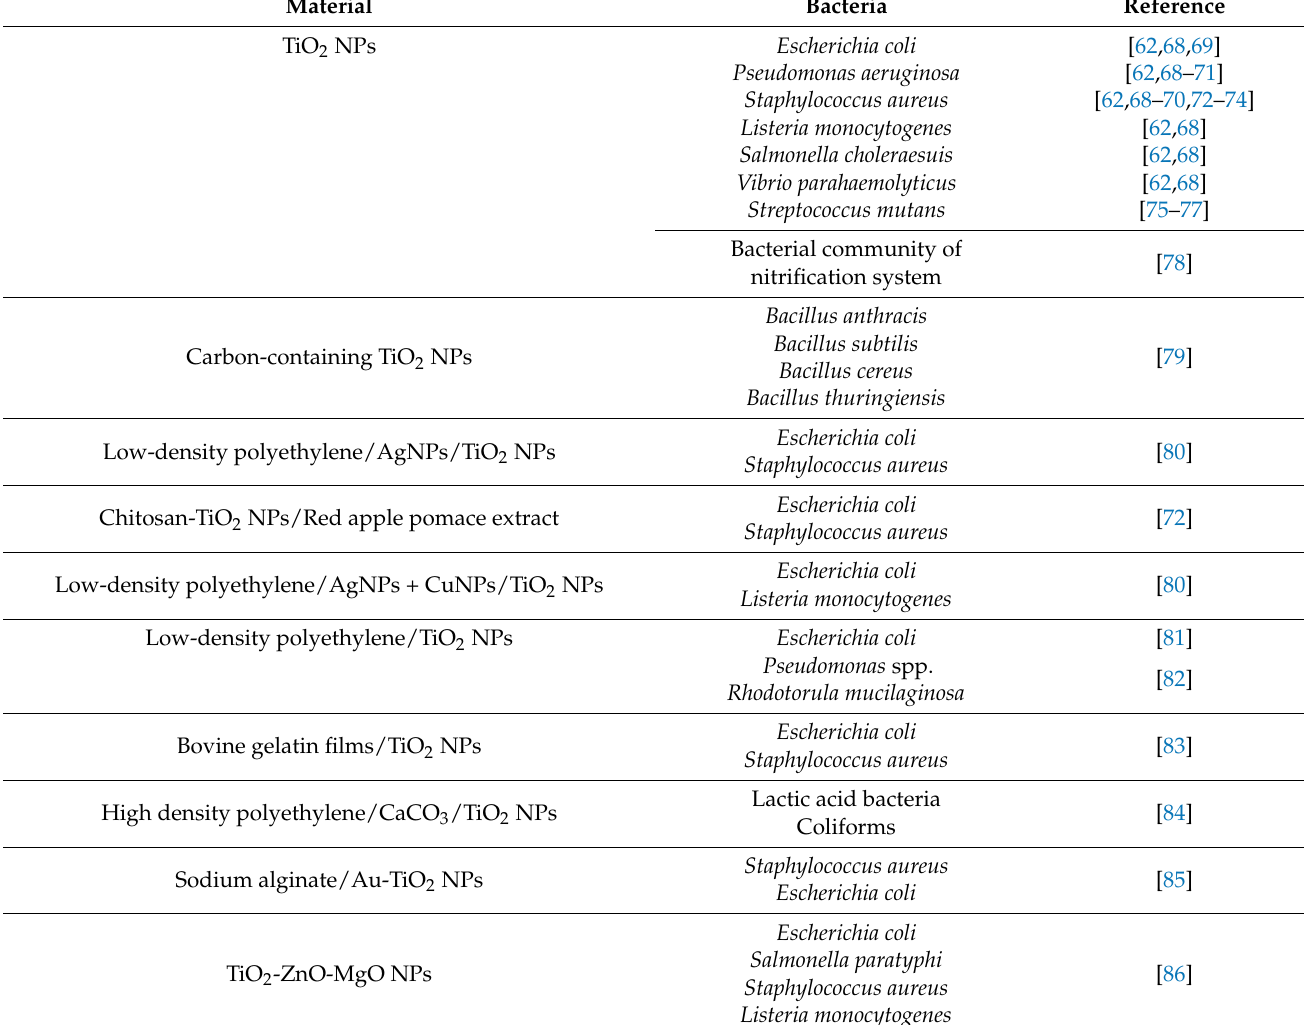
Table 1. TiO 2 NP antibacterial